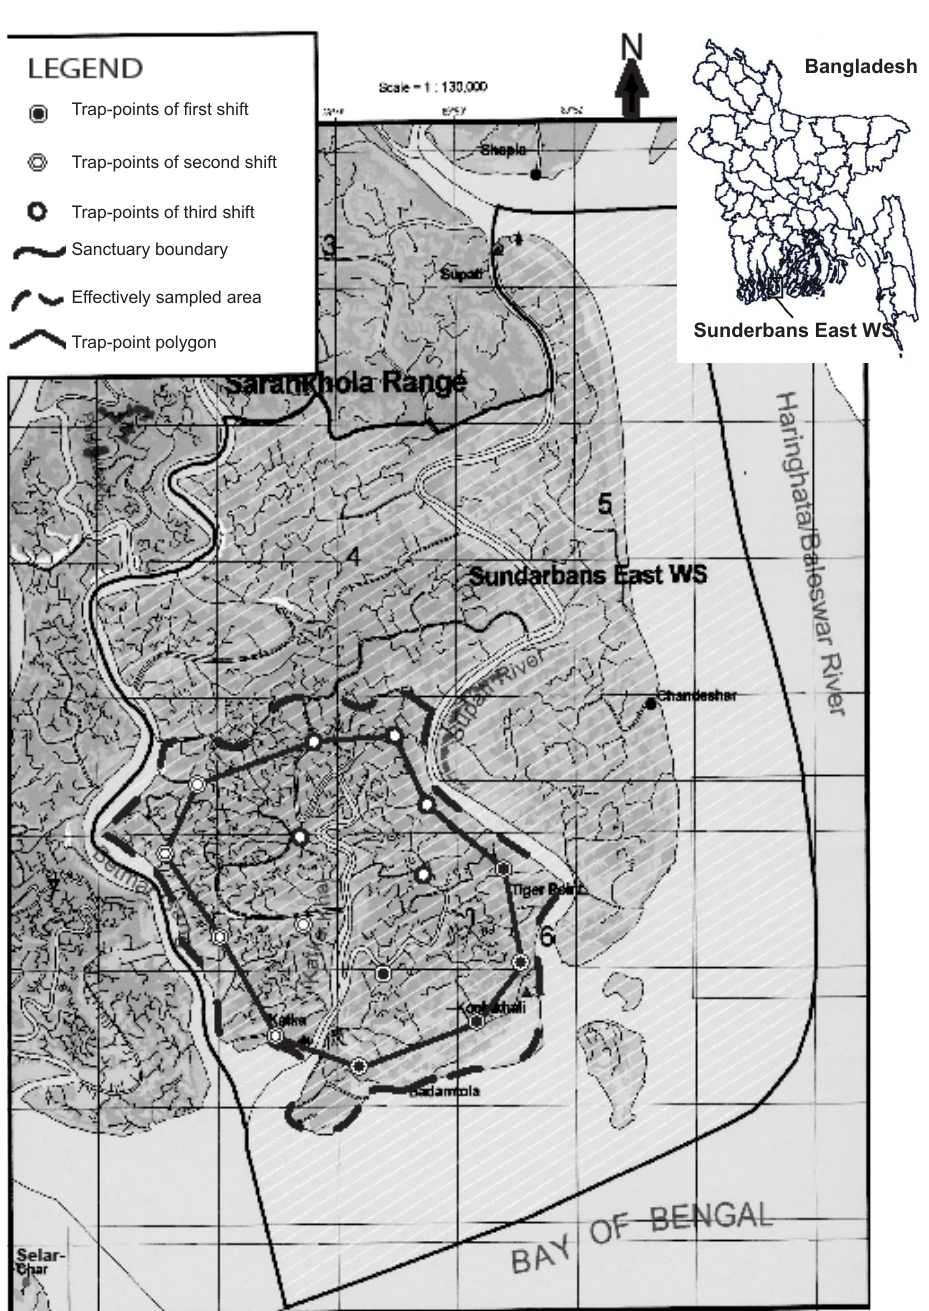
Image 3. The Sundarbans East Wildlife Sanctuary showing 15 trap-points, trap-point polygon and effectively sampled